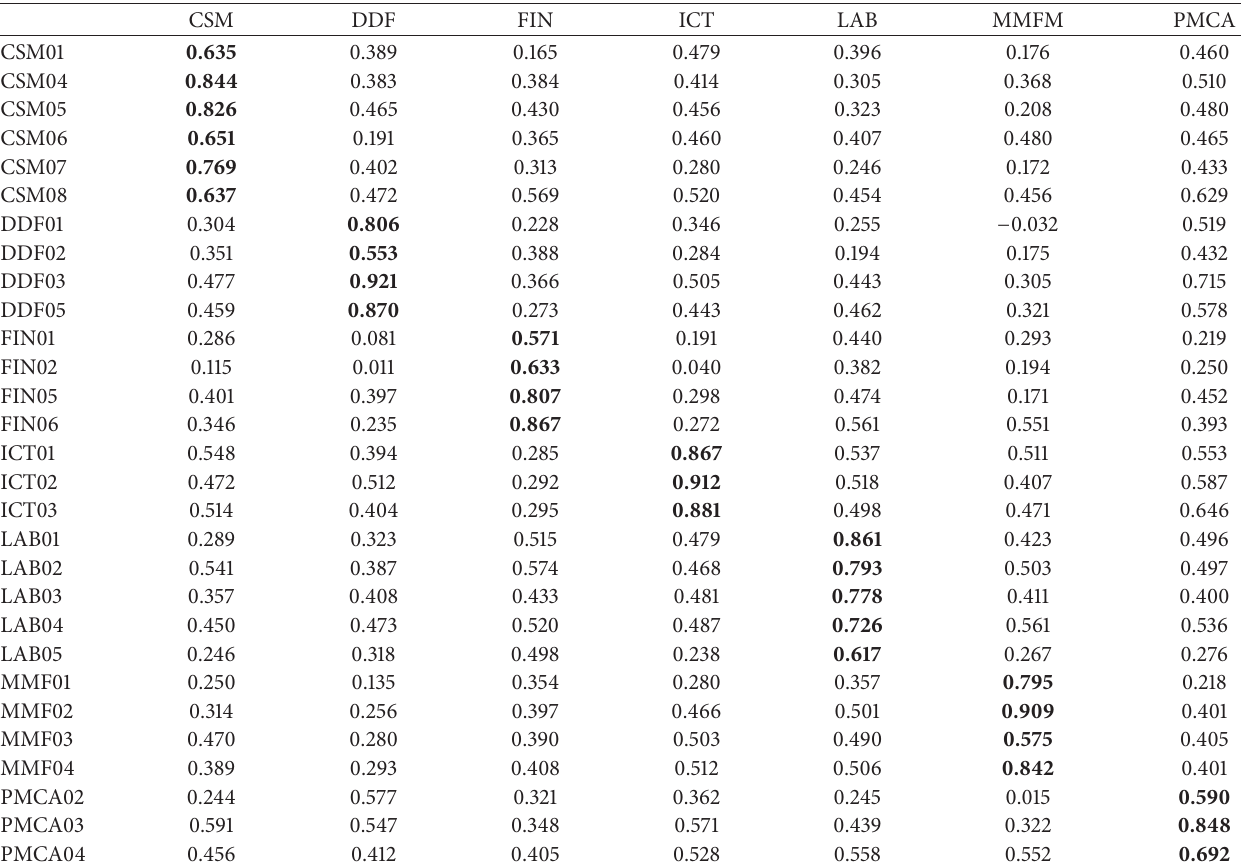
Table 3: Results of cross loading.